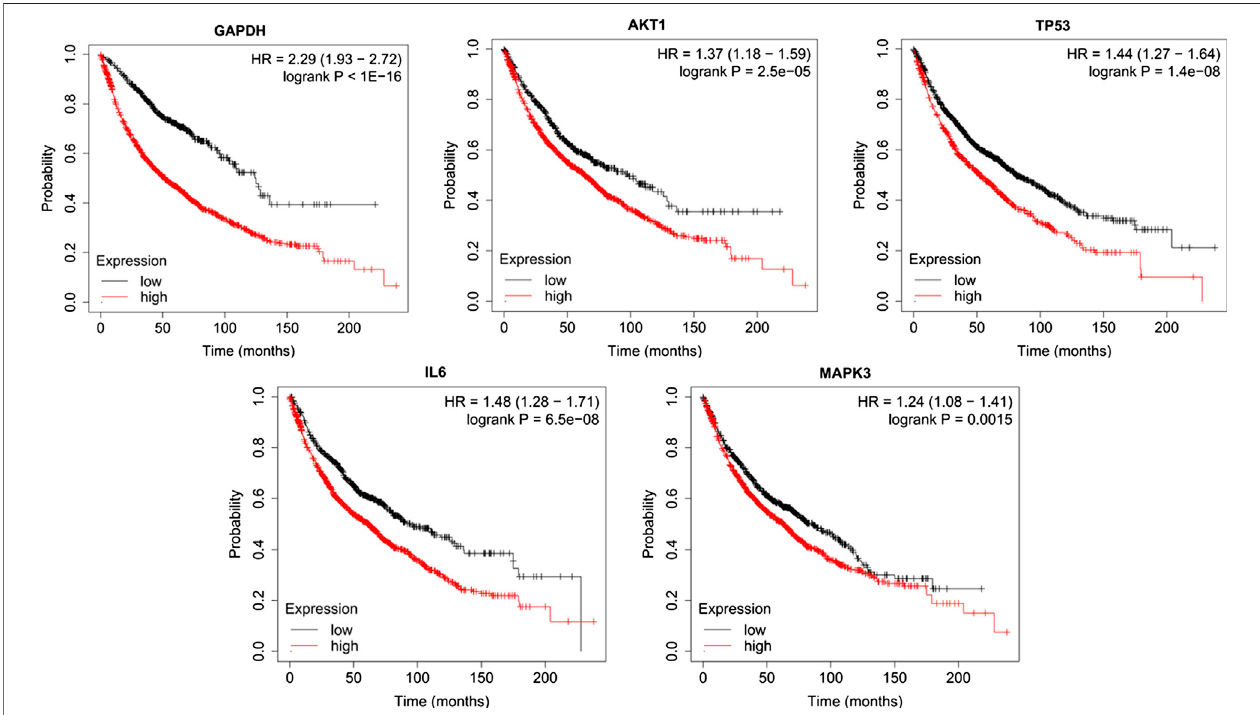
FIGURE 11 | Survival curve of the relationship between high and low expression and overall survival of